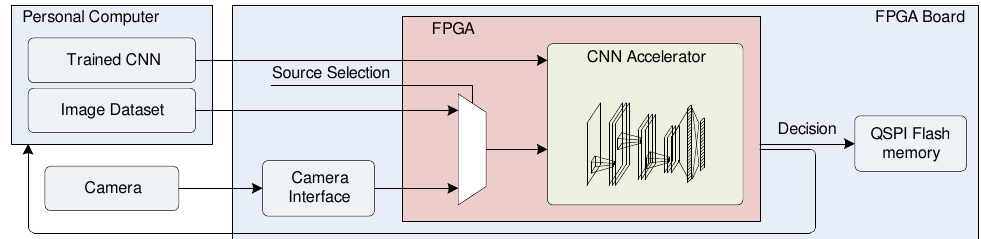
Figure 1. Conceptual illustration of pollen grain detection in